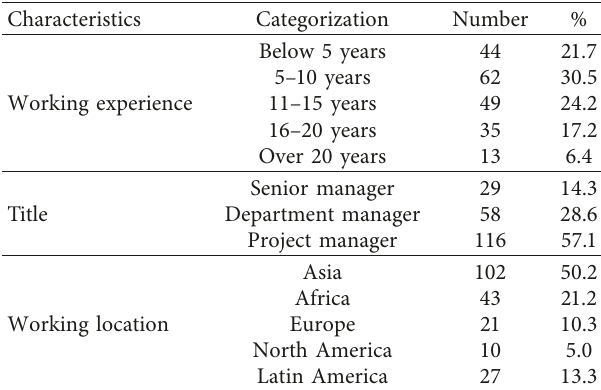
Table 2: Profile of